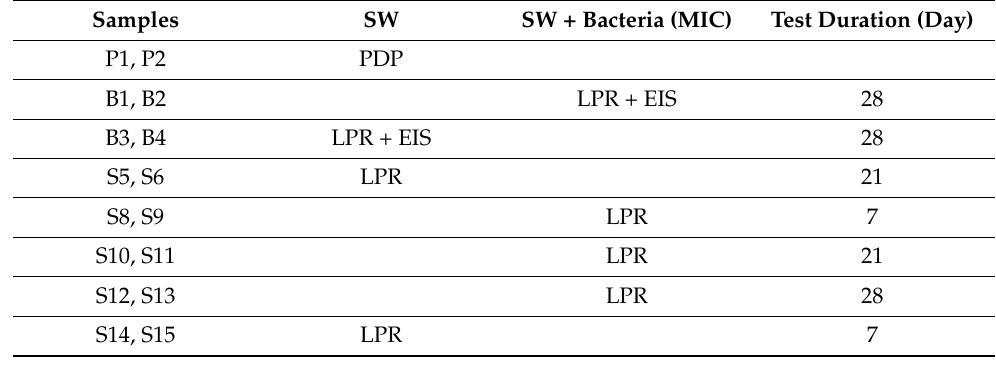
Table 2. Experimental methods and conditions.